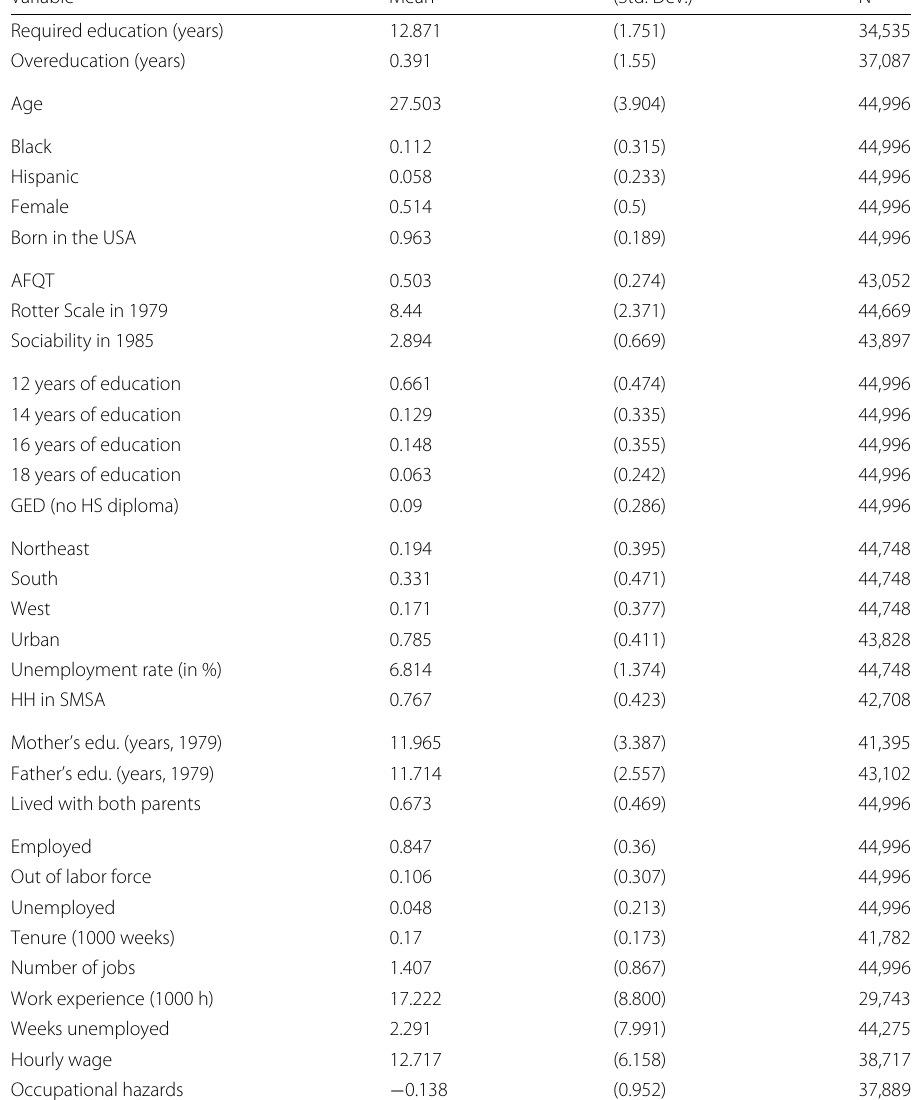
Table 1 Summary statistics: pooled cross section 1982–1994